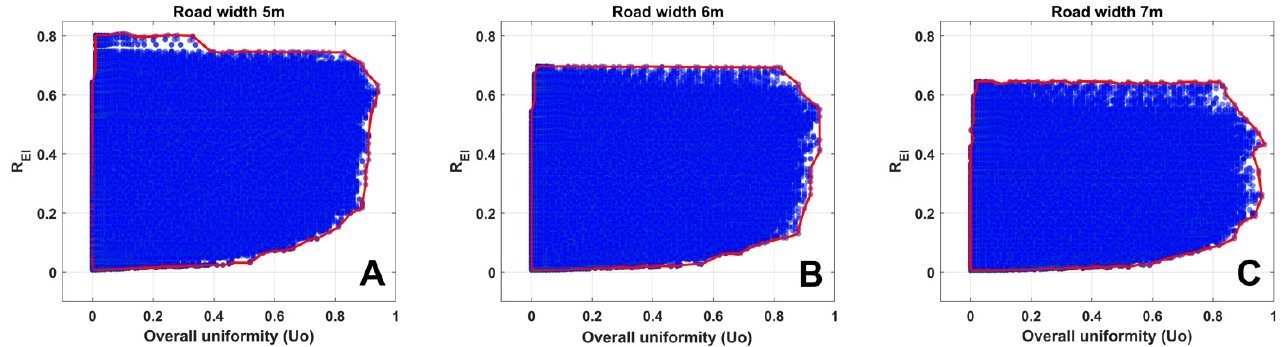
Figure 9. Overall uniformity of illuminance vs. R EI , simulation results for all cases. The graphs include all potential pole arrangements, as shown in Table 1: ( A ) results for road width of 5 m; ( B ) results for road width of 6 m; ( C ) results for road width of 7 m.